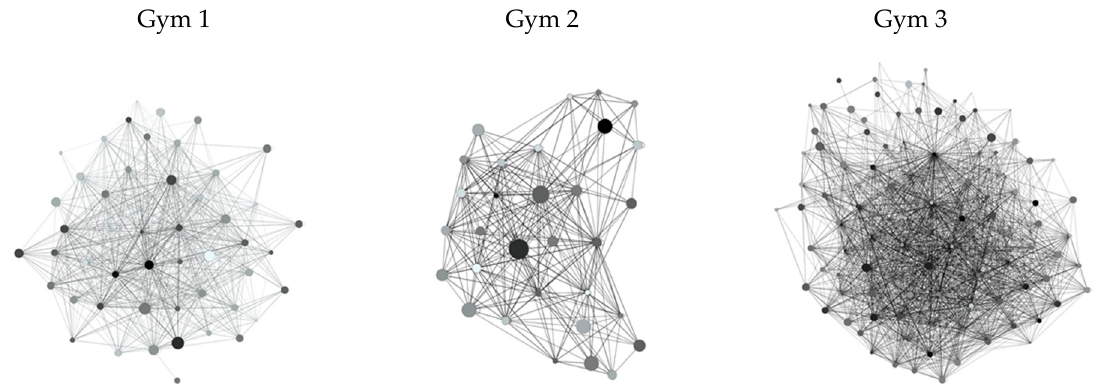
Figure 1. Visualizations of gym networks. Nodes vary in size based on preference score (larger nodes indicate higher preference scores), and nodes are shaded based on tolerance scores (darker nodes indicate higher tolerance scores).